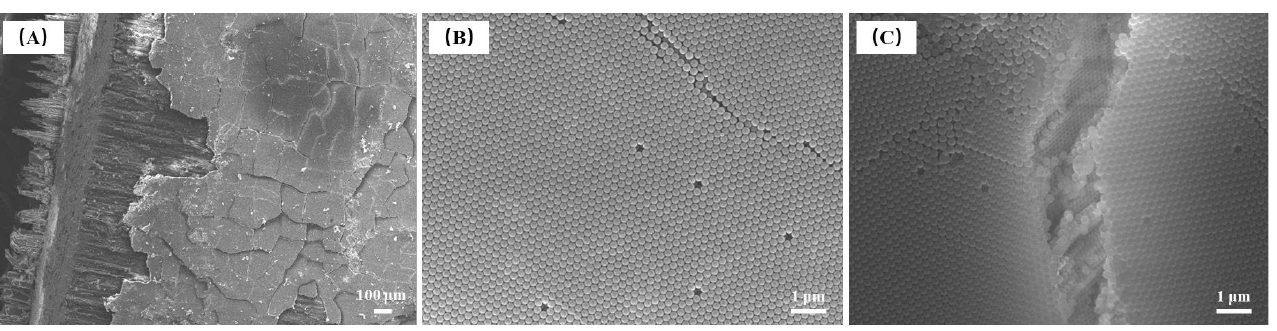
Figure 21. Sectional view FE-SEM images of photonic crystals formed by the self-assembly of P(St- AA) colloidal microspheres on the wood surface: ( A ) micromorphology of photonic crystals and wood; ( B ) low-magnification view of the photonic crystal; ( C ) high-magnification view of the well- ordered part; ( D ) high-magnification view of the disordered part. The coating microstructure consisted of two parts (Figure 21B). The photonic crystal near the coating surface was composed of ordered colloidal microspheres, while the